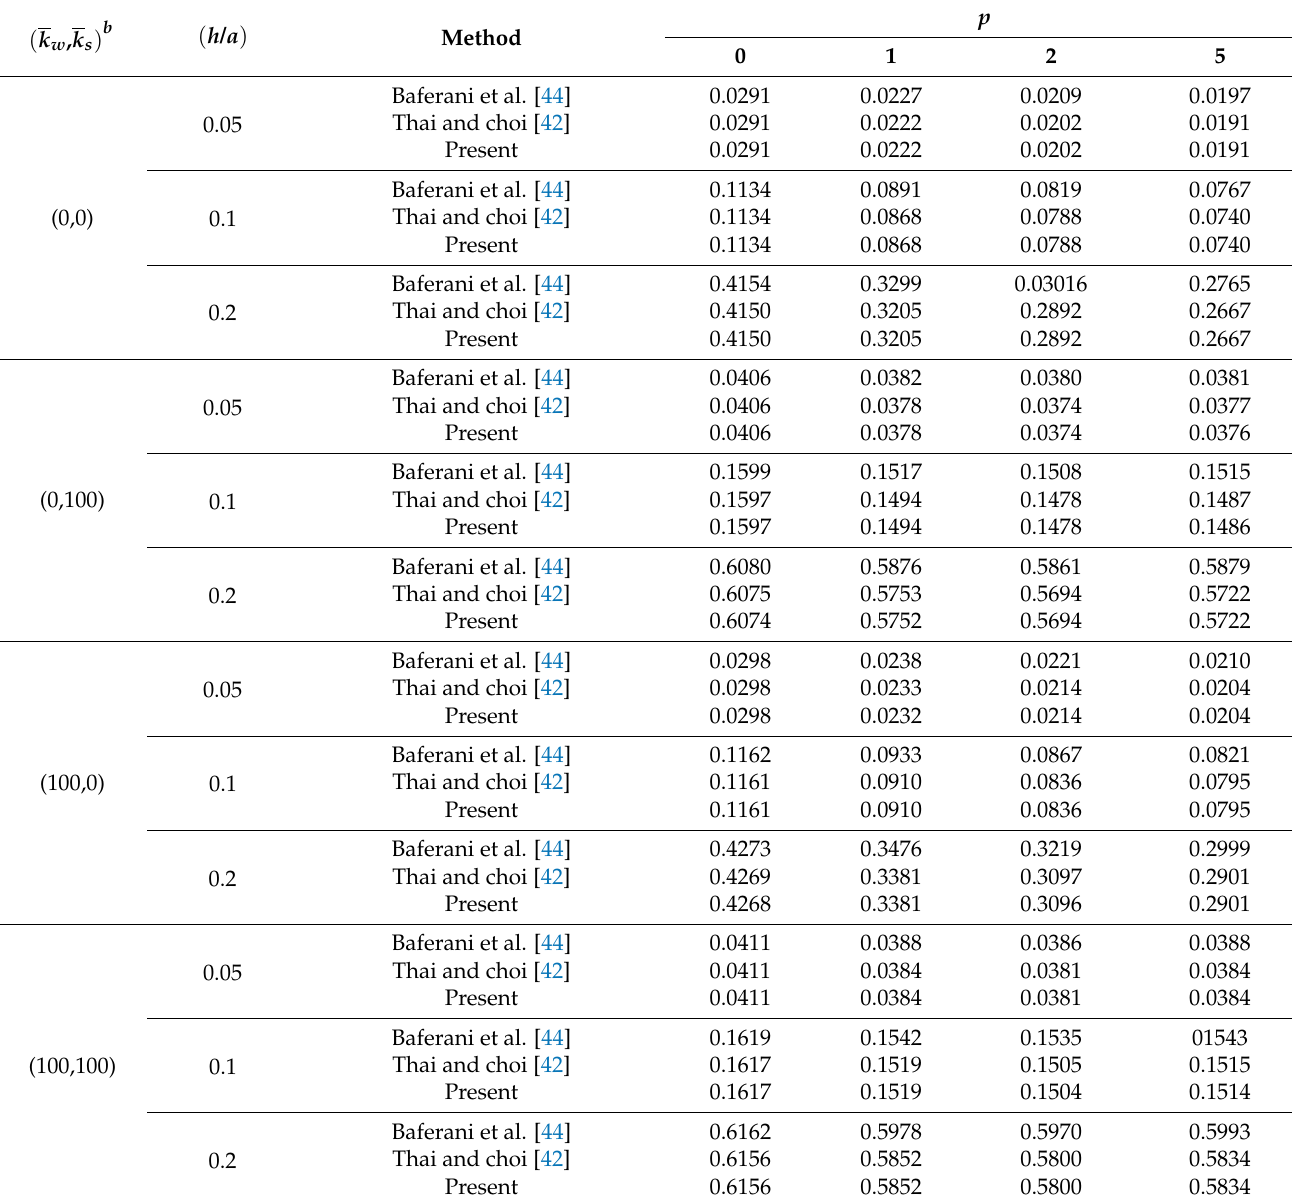
Table 4. Comparison of non-dimensional fundamental frequencies ( ω = ω h graded ( Al / Al 2 O 3 ) plates on elastic